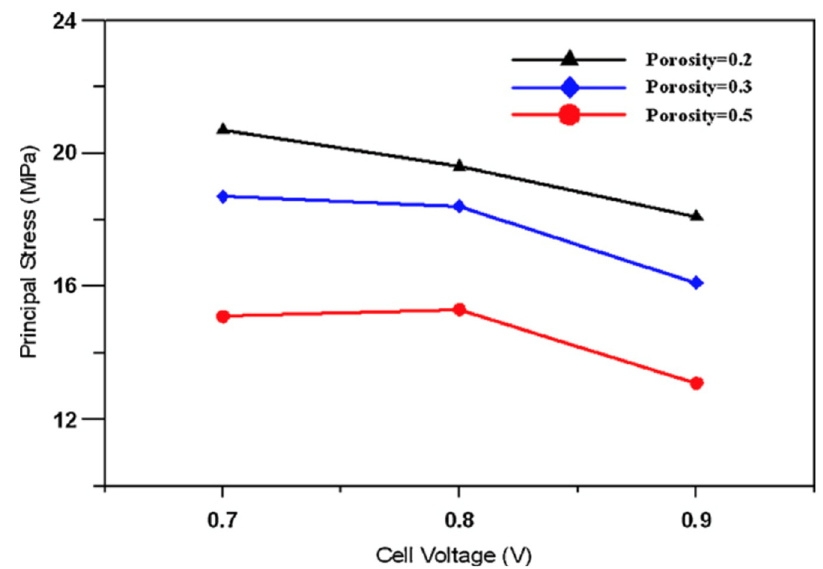
Figure 14. Variation of maximum principal stress in PEN with cell voltage for anode porosities of 0.2, 0.3 and 0.5, respectively (figure reprinted from Chiang et al. [142] Copyright (2010), with permission from Elsevier) [143].